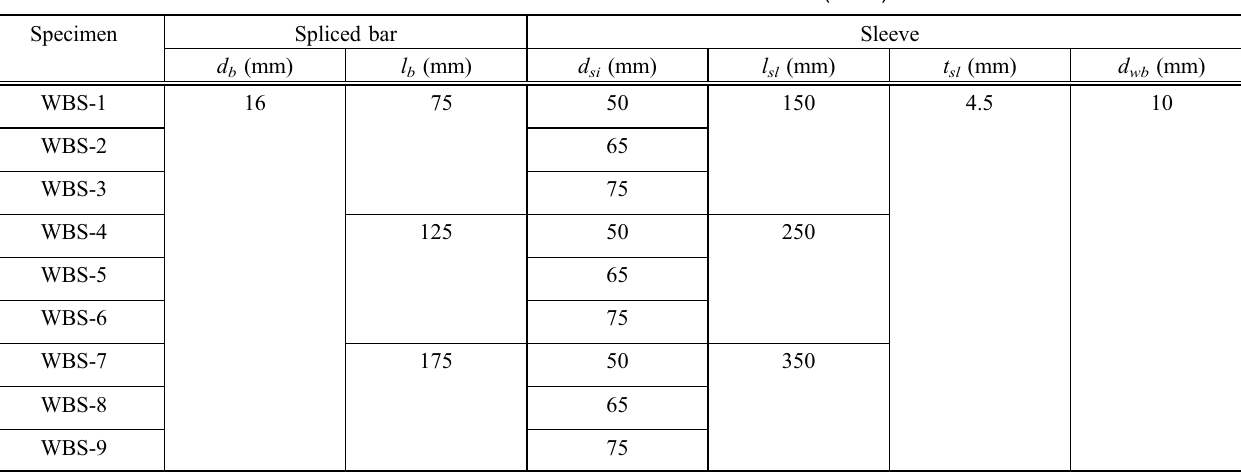
Fig. 5 Schematic design of Welded Bar Sleeve (WBS). Table 1 The dimensions of Welded Bar Sleeve